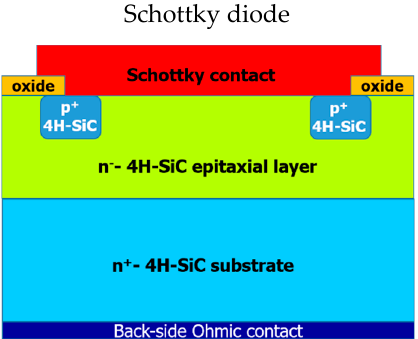
Figure 1. Schematic cross-section view of a 4H-SiC Schottky barrier diode (SBD). The core of an SBD is the metal/semiconductor junction (the so-called Schottky contact) and the properties of this system must be carefully investigated to assess and optimize the electrical performance of the whole device